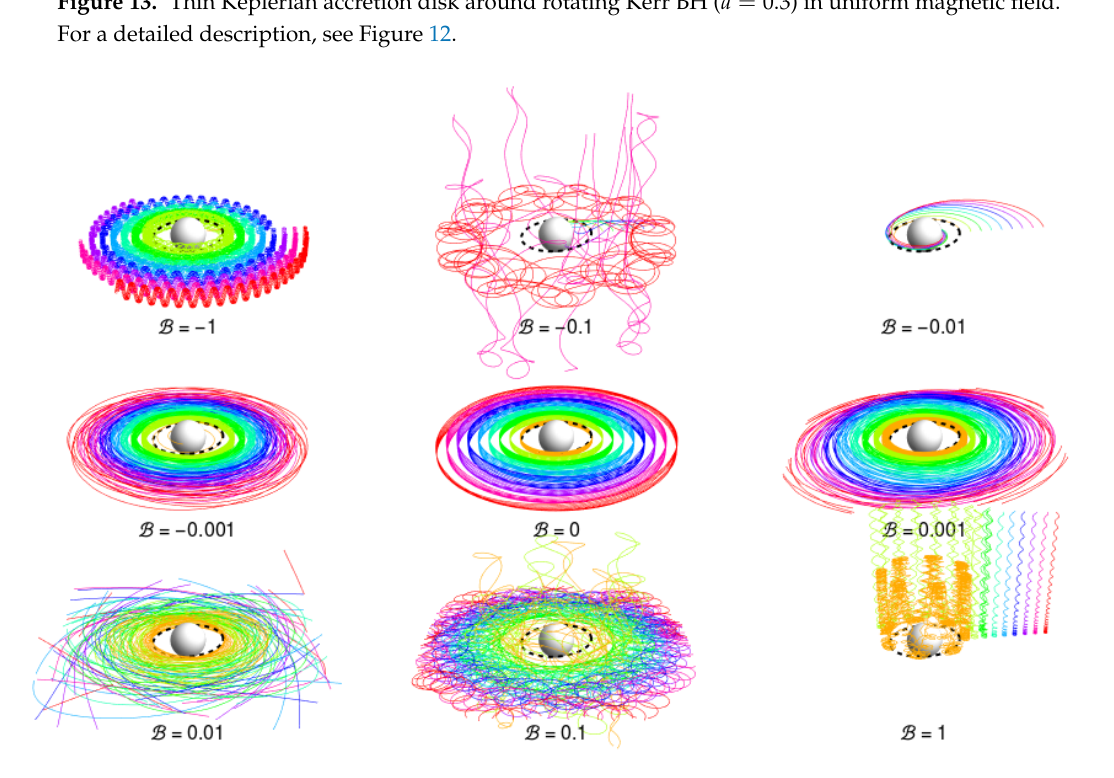
Figure 14. Thin Keplerian accretion disk around rotating Kerr BH ( a = 0.7) in uniform magnetic field. For a detailed description, see Figure